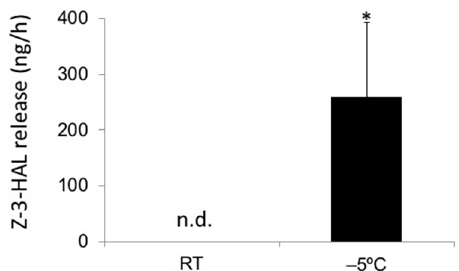
Figure 1. Release of green leaf volatiles from cold stress damaged maize ( Zea mays ) seedlings. Maize seedlings were either placed at − 5 °C or at room temperature (RT), and volatiles were collected for 1 h ( n = 4). Values are means ± standard deviation (SD), and asterisks indicate significant differences between treated and untreated seedlings ( t -test, p < 0.05; n.d., not detectable).